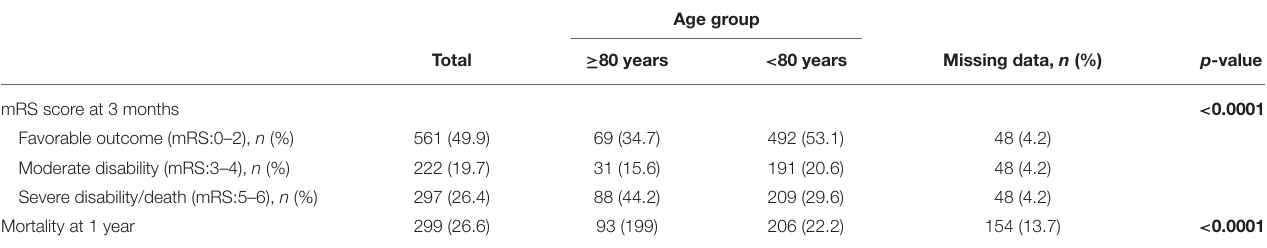
TABLE 5 | mRS score at 3 months and 1-year mortality in patient groups above and under 80 years.